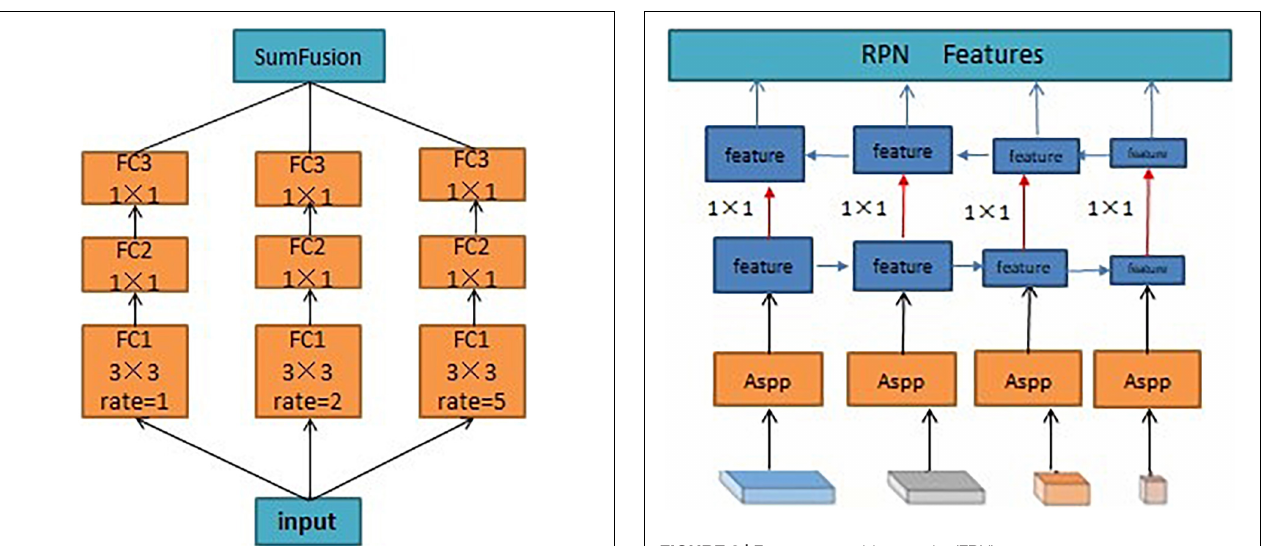
FIGURE 8 | Feature pyramid networks (FPN)